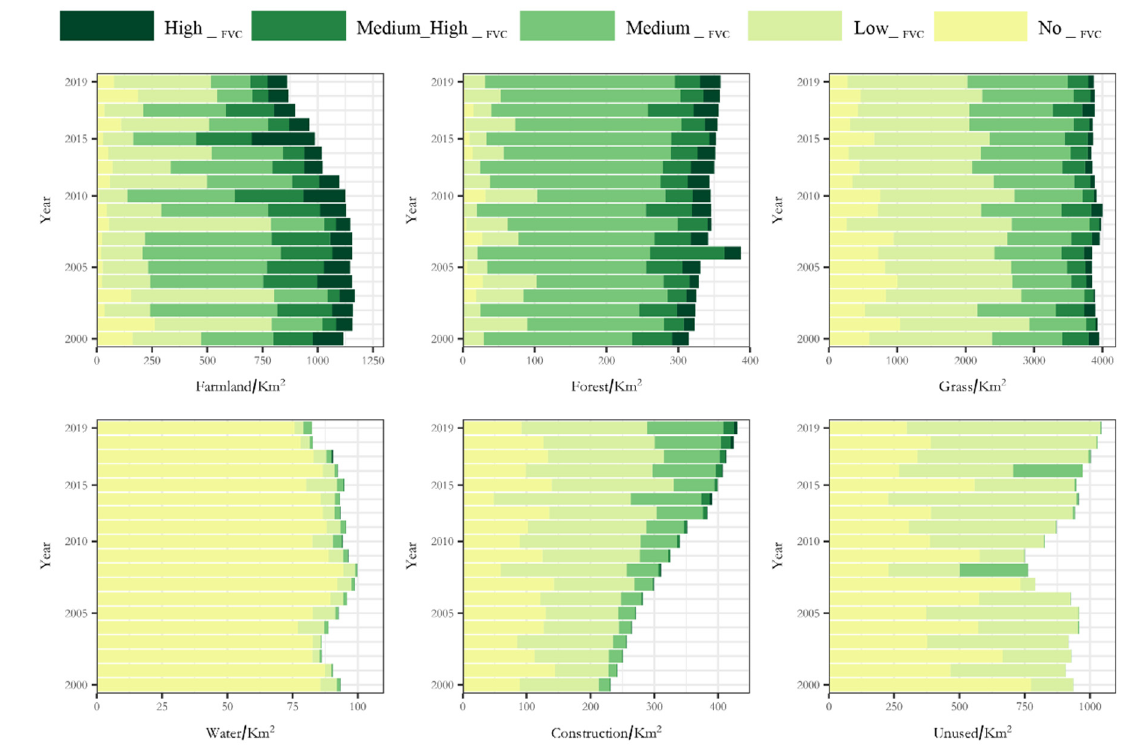
Figure 5. Proportion of FVC for each land use type from 2000 to 2019.